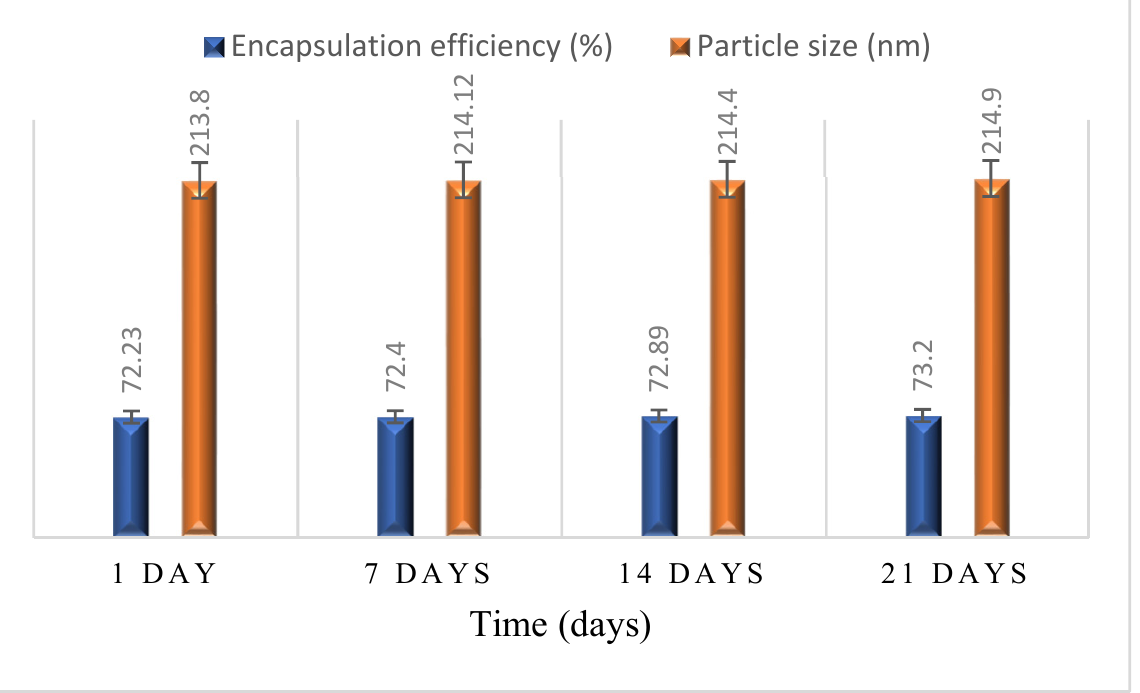
Figure 7. Stability studies of MTX loaded AEM/CS NPs over a time duration of 21 days in mean ± S.D ( n = 3).